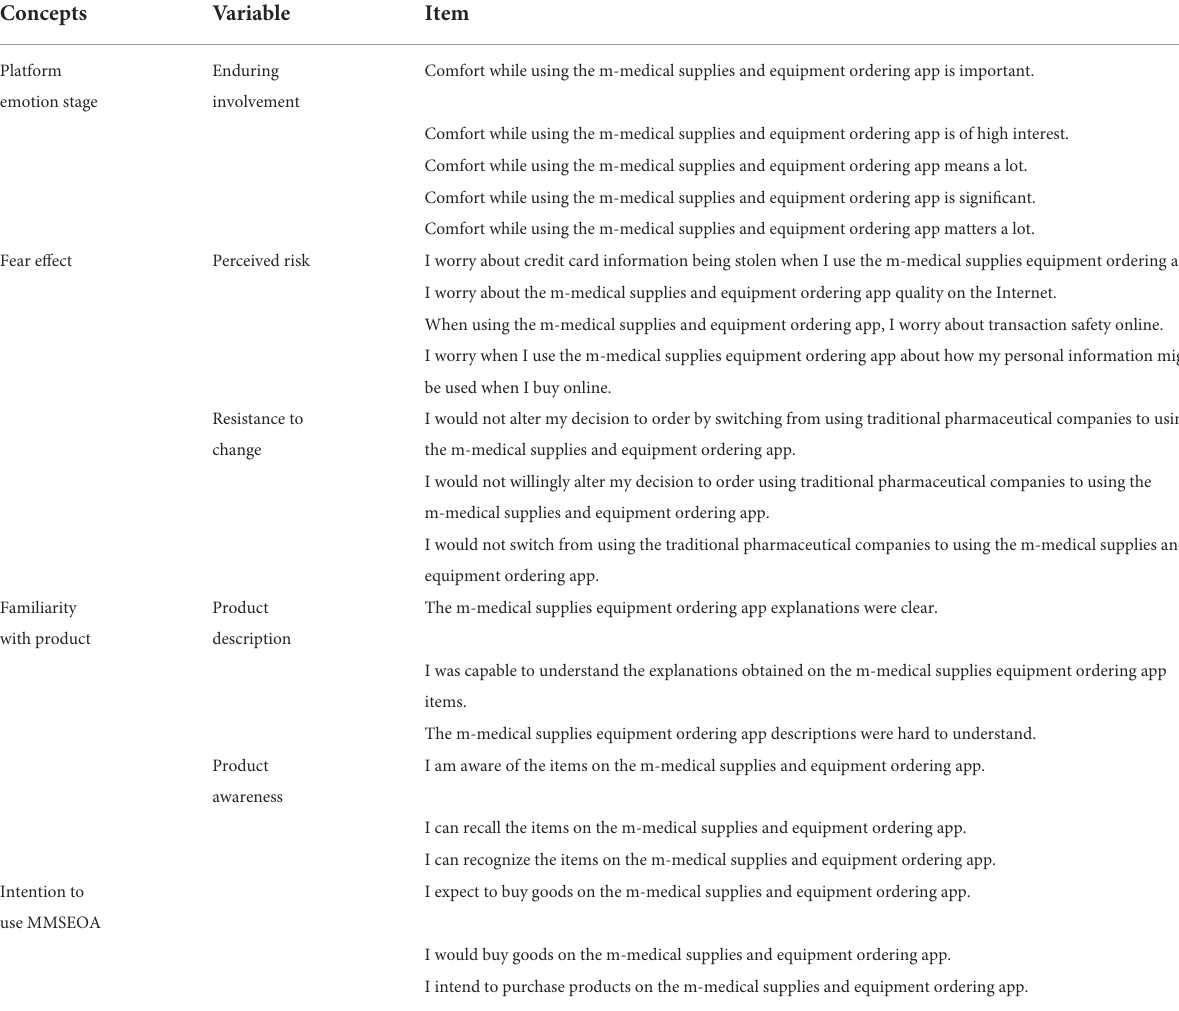
TABLE 2 Questionnaire